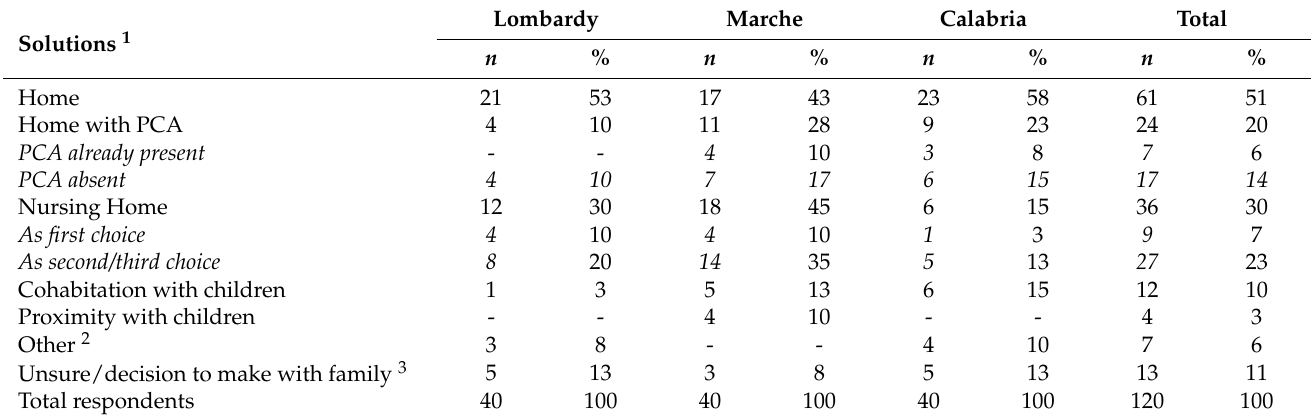
Table 3. Preferred future housing solutions by region ( n ;